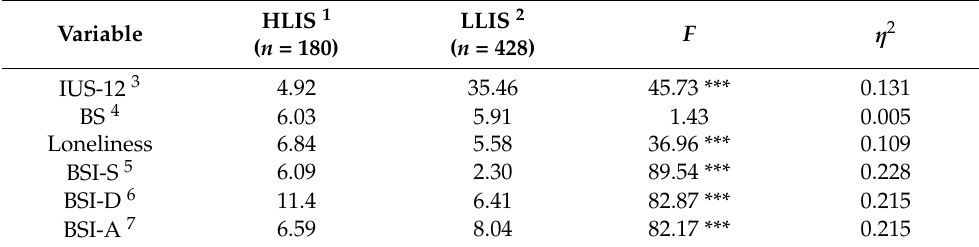
Table 2. Multivariate analyses of covariance, between LLIS and HLIS clusters, in the study variables during the